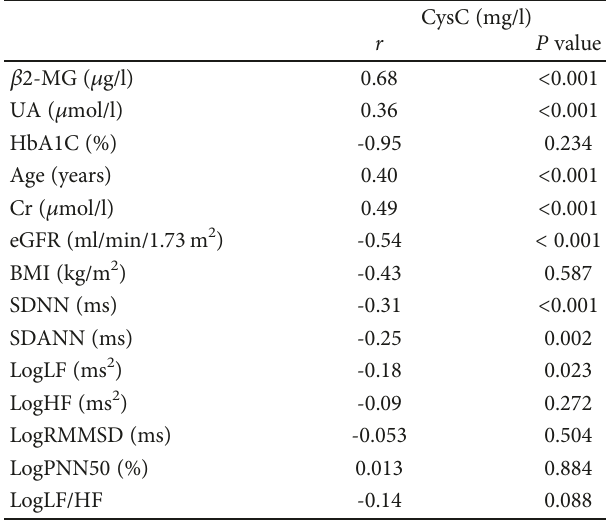
Figure 1: Determination of the HRV indexes in patients with di ff erent levels of CysC. (a) Determination of SDNN values in patients with di ff erent levels of CysC yielded a statistically signi fi cant trend when SDNN values were compared. Means ± SD of SDNN values for CysC 1: 110 10 ± 30 6 ms ; CysC 2: 114 02 ± 34 7 ms ; and CysC 3: 86 37 ± 26 8 ms . (b) Determination of SDANN values in patients with di ff erent levels of CysC yielded a statistically signi fi cant trend when SDANN values were compared. Means ± SD SDANN values for CysC 1: 100 75 ± 28 9ms ; CysC 2: 104 32 ± 34 3ms ; and CysC 3: 83 76 ± 31 5 ms . Table 3: Relationship between CysC and other measurements in Table 2: The values of CysC and the HRV indexes in patients of all di ff erent ages.